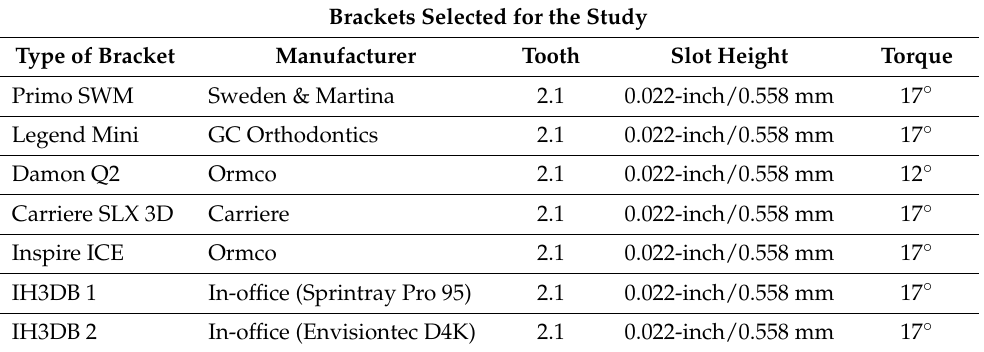
Table 1. Description of the sample for each type of bracket investigated. Brackets Selected for the